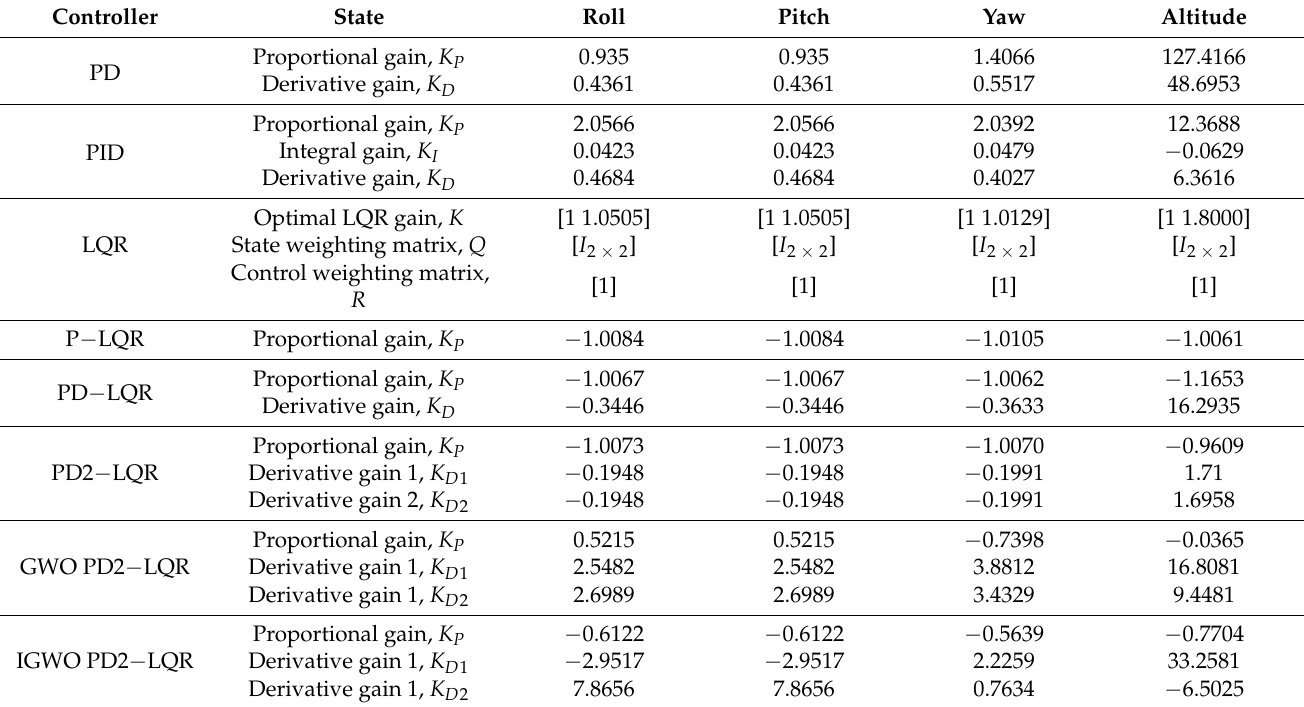
Table 2. The parameters of the controller (Model